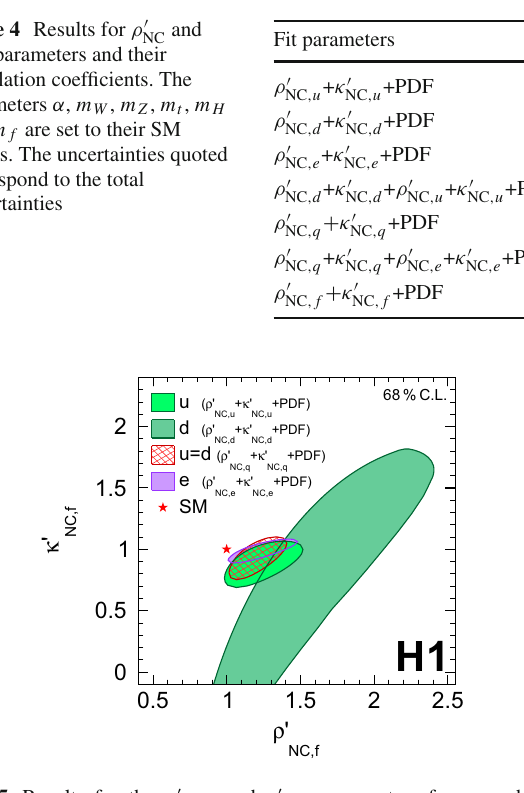
Fig. 5 Results for the ρ (cid:6) and κ (cid:6) parameters for u - and d - NC , f NC , f type quarks and electrons at 68% confidence level (CL), obtained with the ρ (cid:6) + κ (cid:6) +PDF, ρ (cid:6) + κ (cid:6) +PDF and ρ (cid:6) + κ (cid:6) +PDF fits, NC , u NC , u NC , e NC , e NC , d NC , d respectively. The SM expectation is displayed as a star. The contour of the d -type quark is truncated due to the limited scale of the panel. For comparison, also the result of the ρ (cid:6) + κ (cid:6) +PDF fit is dis- NC , q NC , q played, where quark universality is assumed ( u = d ). The results of